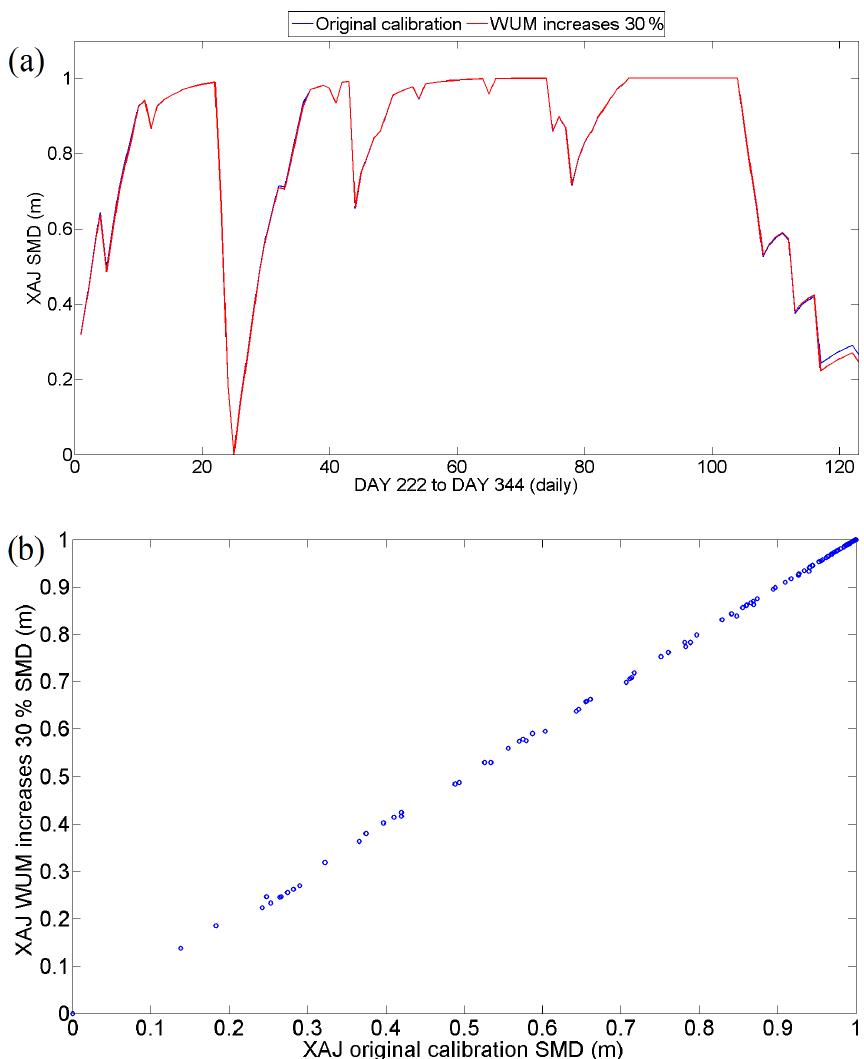
Figure 12. Normalised SMD variations from the manipulated XAJ calibration (i.e., the WUM parameter is increased by 30%) and its original